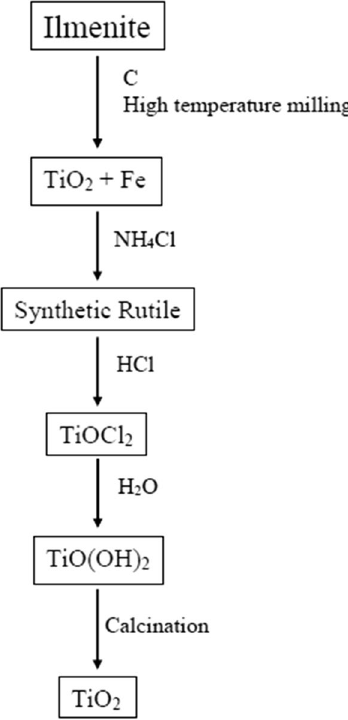
Fig. 10 Stepwise production of TiO from ilmenite via the 2 treatment in ammonium